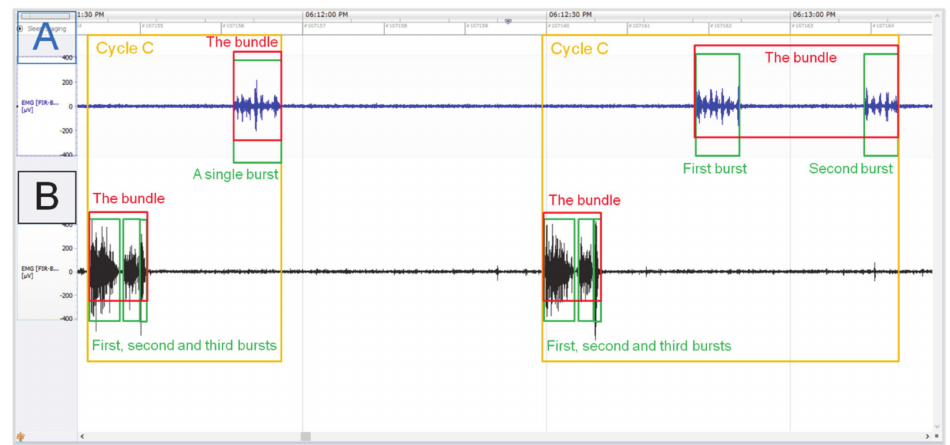
Figure 3. The representative images of the EMG signal recording in the reticulo-rumen, representing cycle C. Selected Myo- electrical activity of the rumen ( A ); myoelectrical activity of the reticulum ( B ). NeuroScore analysis software, 1 min